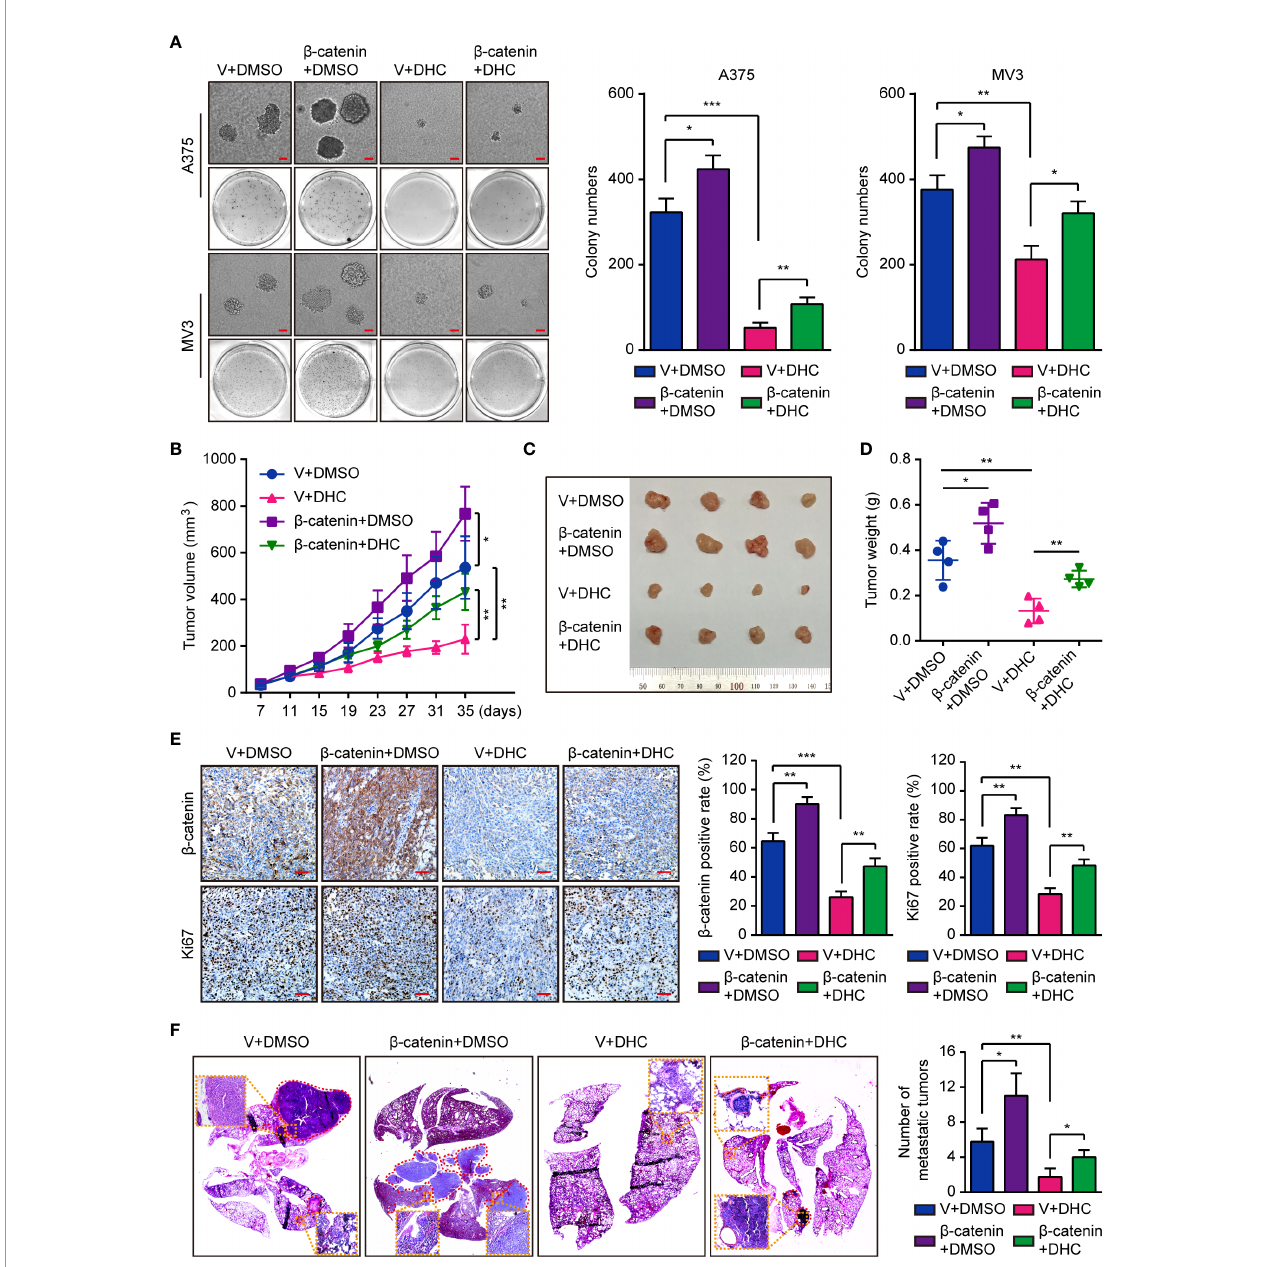
FIGURE 6 | Overexpression of b -catenin retrieves DHC-induced inhibition of tumor growth and pulmonary metastasis of melanoma cells. (A) Colonies generated by b -catenin/vector overexpressed A375 and MV3 cells after treatment with 100 m M DHC for 3 weeks. Scale bar, 1 mm. (B) Tumor volume of b -catenin/vector overexpressed A375 xenograft tumors in mice after treatment with DHC (20 mg/kg/day for 28 days) and DMSO. (C, D) The tumors in mice were excised and weighed. (E) IHC of b -catenin and Ki67 in the xenograft tumors. Scale bar, 100 m m. (F) H&E staining of the lungs from b -catenin/vector overexpressed A375 metastasis mice model after treatment with DHC (20 mg/kg/day for 45 days) and DMSO. * P <0.05; ** P <0.01; *** P <